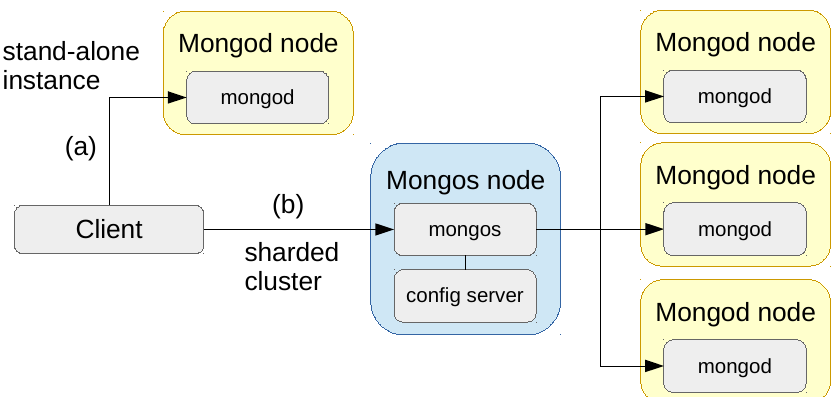
Figure 4. Deployment of ( a ) a single stand-alone MongoDB document store and ( b ) a sharded MongoDB